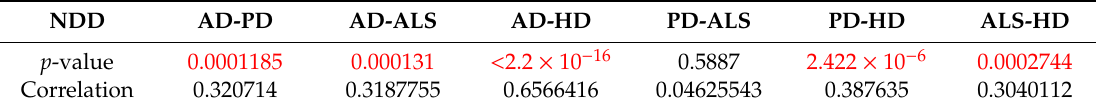
Table 3. Results of the one stratum analysis of the linear regression model calculated with the cor.test function in R. The p -value and correlation values are given for all pairwise comparisons of the analyzed NDDs. The analyzed values are the mean direction of regulation of all transcriptomic data kept after intersecting the four NDDs. p -Values < 0.05 are shown in